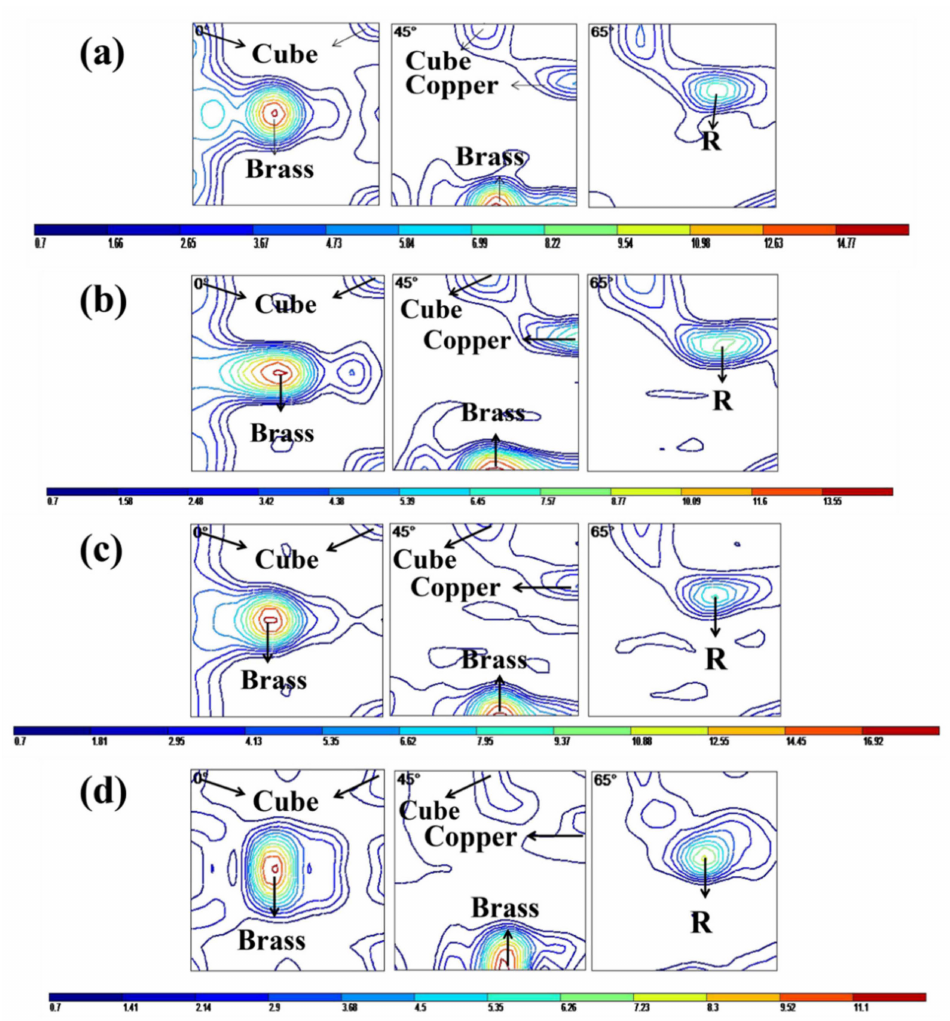
Figure 8. ODF results of the 120 mm hot rolled plate after solution at 477 ◦ C for: ( a ) 30 min, ( b ) 90 min, ( c ) 210 min, ( d ) 330 min.